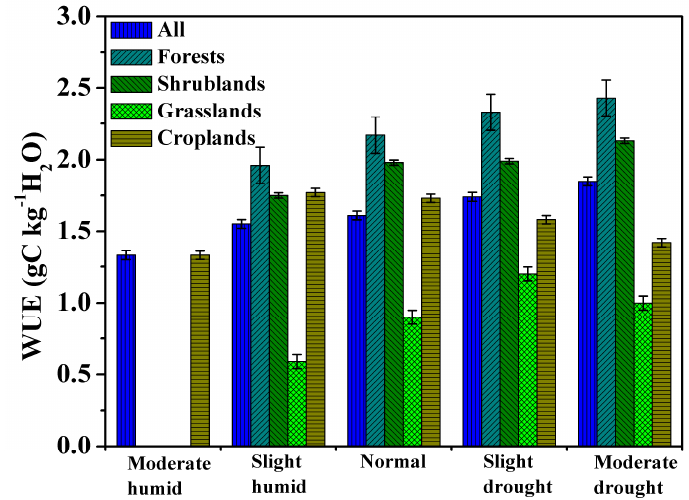
Figure 6. Mean annual WUE spatially averaged for all vegetated grid cells and each of the four broad vegetation types under different wet or dry conditions.